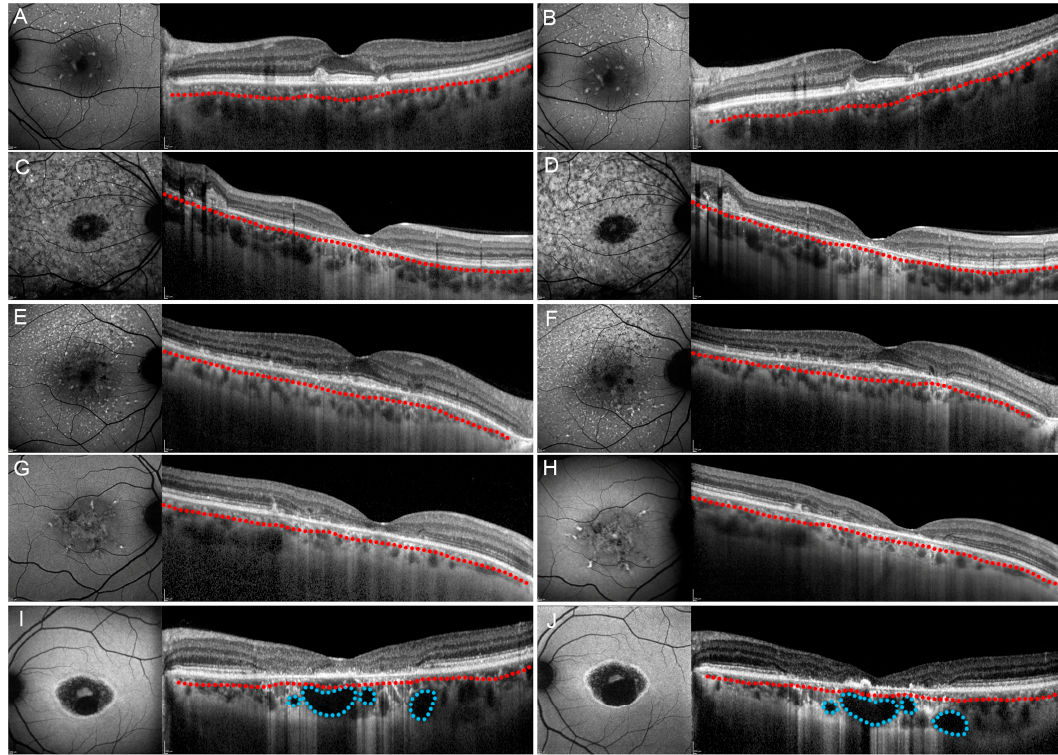
Figure 3. Stargardt disease progression after one year. Fundus autofluorescence-FAF is shown on the left and structural optical coherence tomography-OCT is shown on the right parts of each image. Pattern 1 ( A , B ), Pattern 2 (reduced Sattler layer) ( C , D ) and Pattern 2 (reduced Haller layer) ( E , F ) showed unremarkable changes both on FAF and structural OCT after one year, followed by unremarkable changes of best corrected visual acuity (BCVA). On the contrary, Pattern 3 ( G , H ) and Pattern 4 ( I , J ) showed both imaging and BCVA worsening after one year. In all images, Sattler and Haller layers are separated by a red dotted line. Moreover, choroidal cavers are highlighted by blue dotted lines.